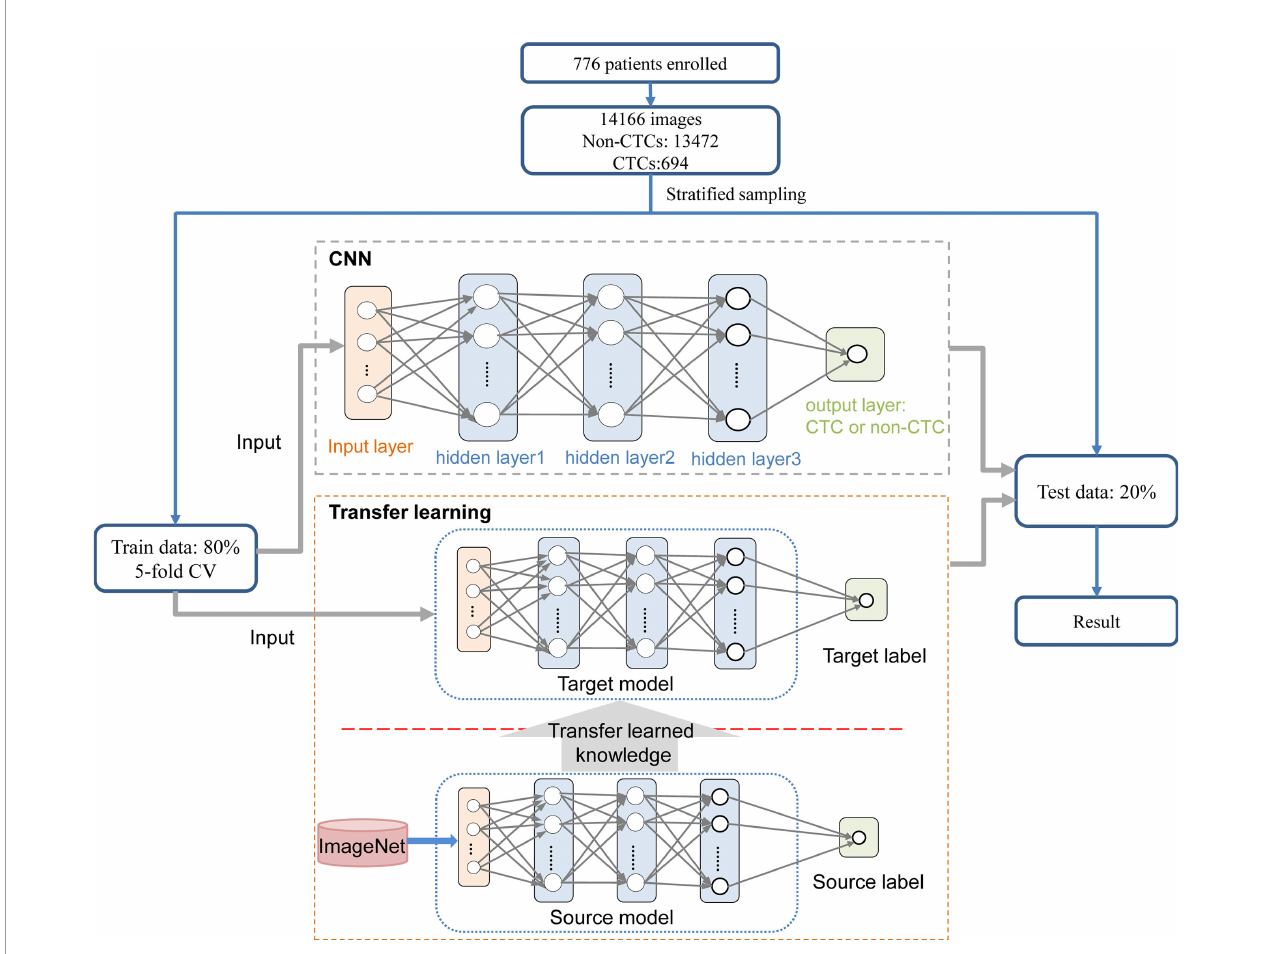
FIGURE 3 | Process for identifying CTC. On the training set, the traditional CNN model and transfer learning model were respectively trained based on 5-fold CV. The transfer learning model relied on the pre-trained CNN model to realize the task of CTC recognition. The trained traditional CNN model and the transfer learning model were used to test sets and output the fi nal